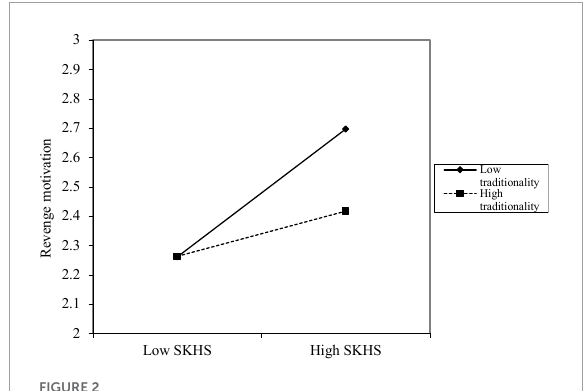
FIGURE2 Moderation effect of different levels of traditionality on the relationship between SKHS and subordinate revenge